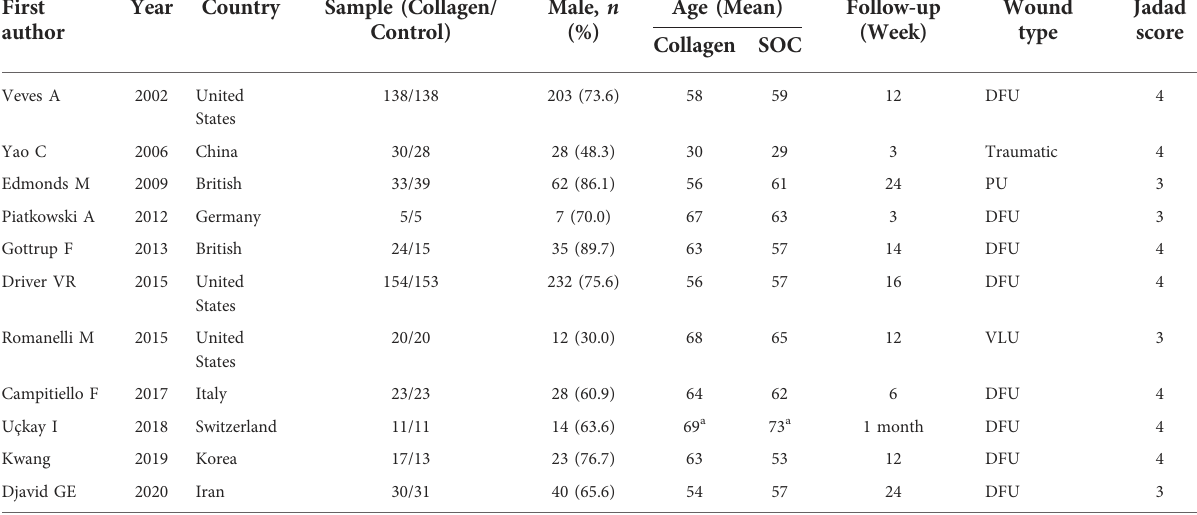
TABLE 1 Description of the studies in the